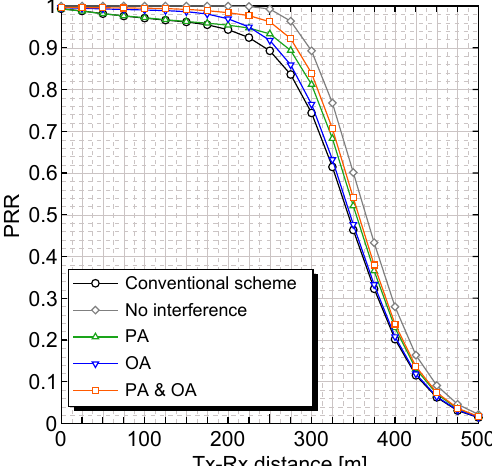
Figure 12. Effect of the PRR for generation pattern 2.